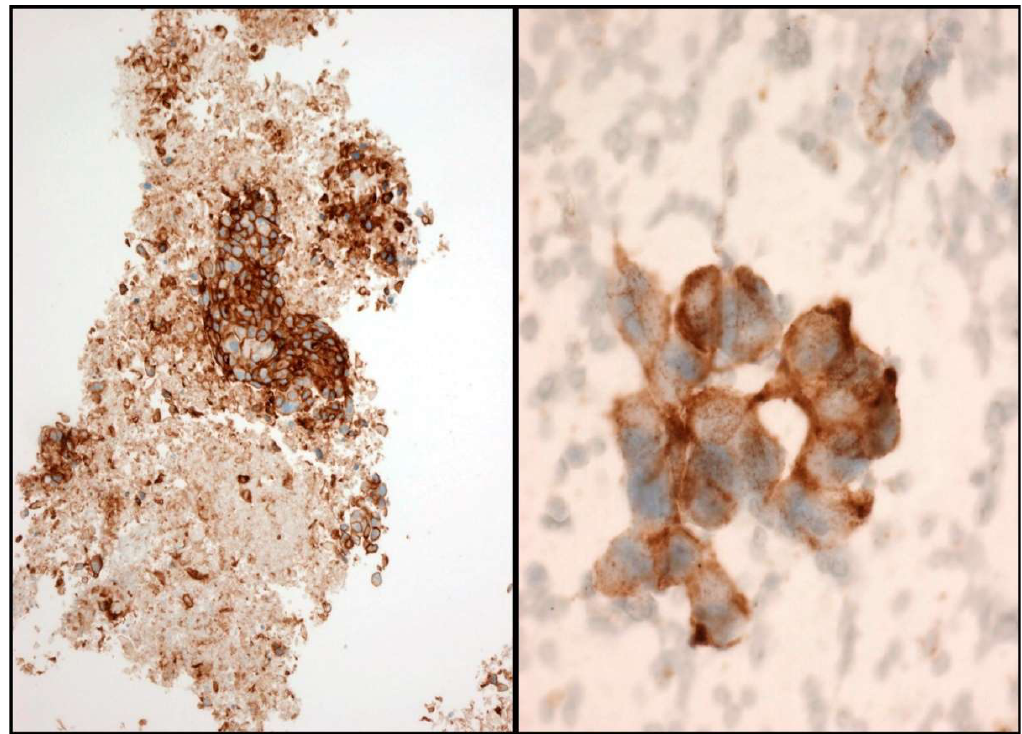
Figure 5. Some examples of PD-L1 immunostaining. Cell-block ( Left ) and smear ( Right ).